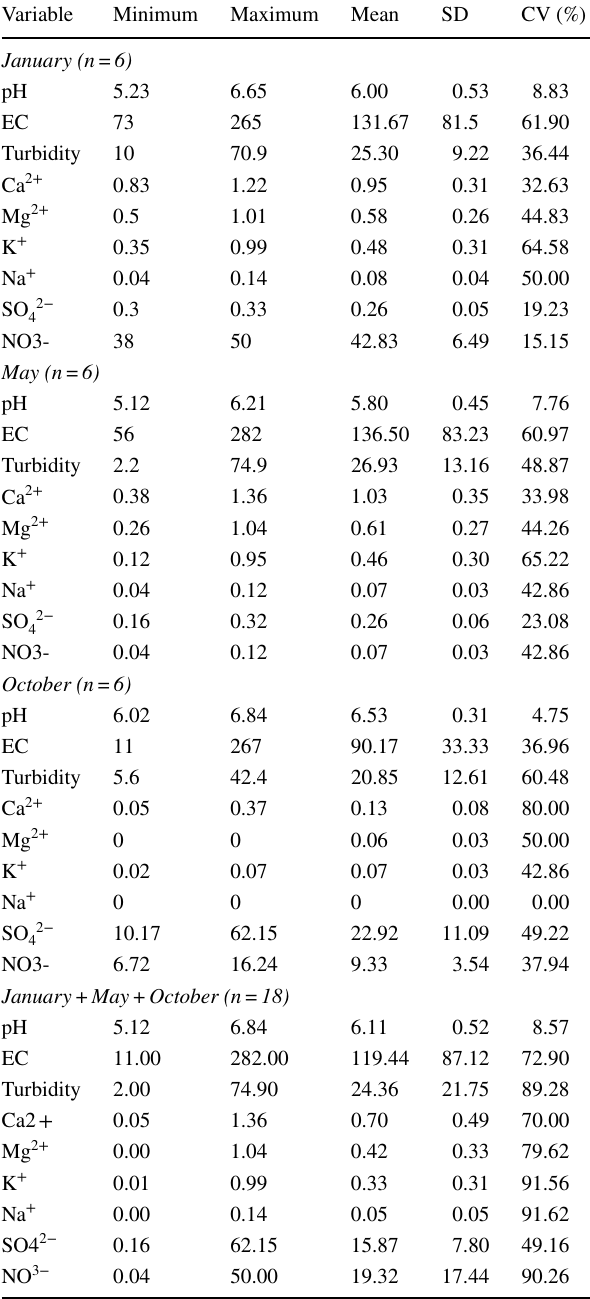
Table 2 Summary statistics of the Mezam water physico-chemical characteristics for the studied